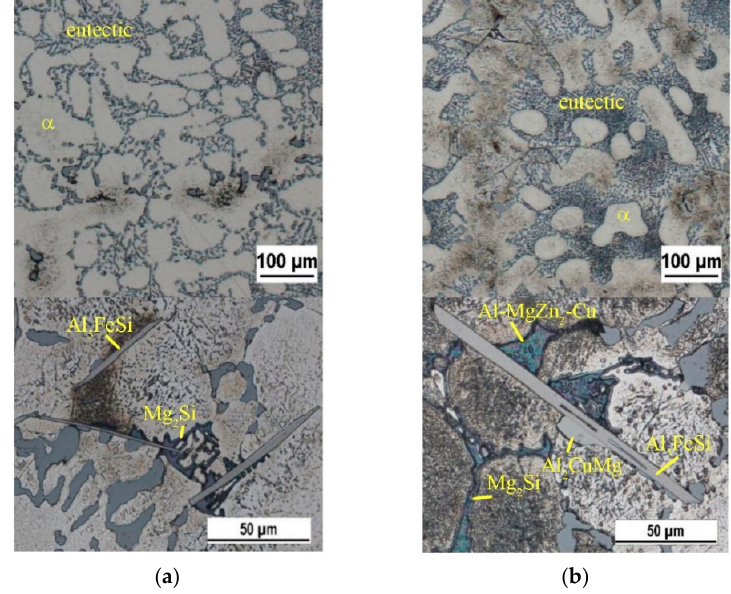
Figure 3. Microstructure of AlZn10Si8Mg cast alloys, etch. Dix-Keller. ( a ) alloy D with 0.150 wt. % Fe; ( b ) alloy E with 0.559 wt. %